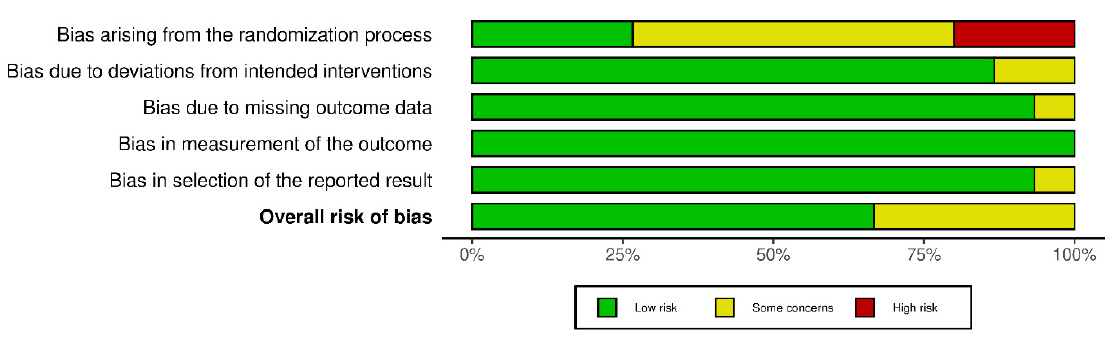
Figure 3. Overall Risk of Bias (Randomized Controlled Parallel Studies).